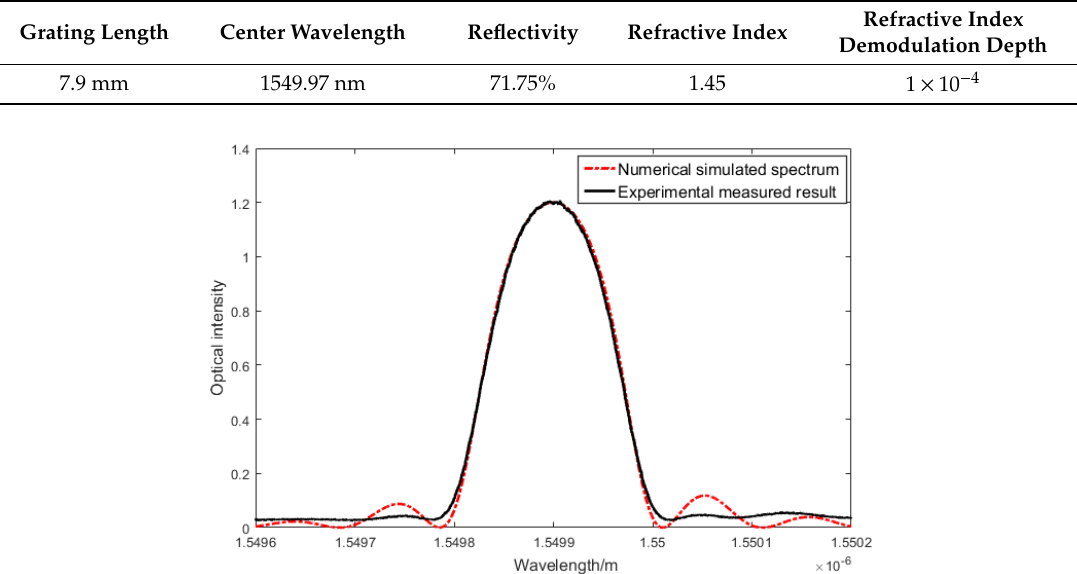
Table 1. Fiber Bragg Grating (FBG) sensor parameters.